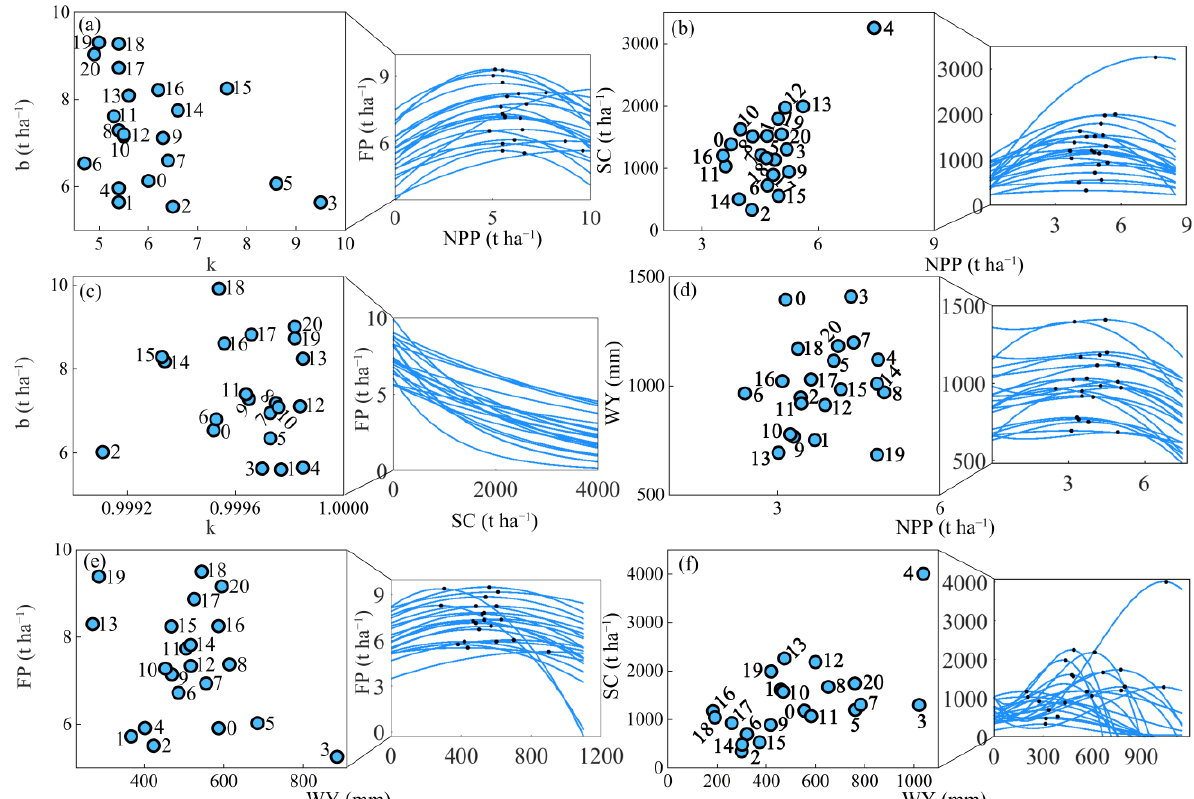
Figure 7. The box plots of thresholds on the constraint lines of NPP_SC, NPP_WY, WY_FP, NPP_FP and WY_SC. NPP: net primary productivity; FP: food production; SC: soil conservation; WY: water yield. Diamond represents outliner.